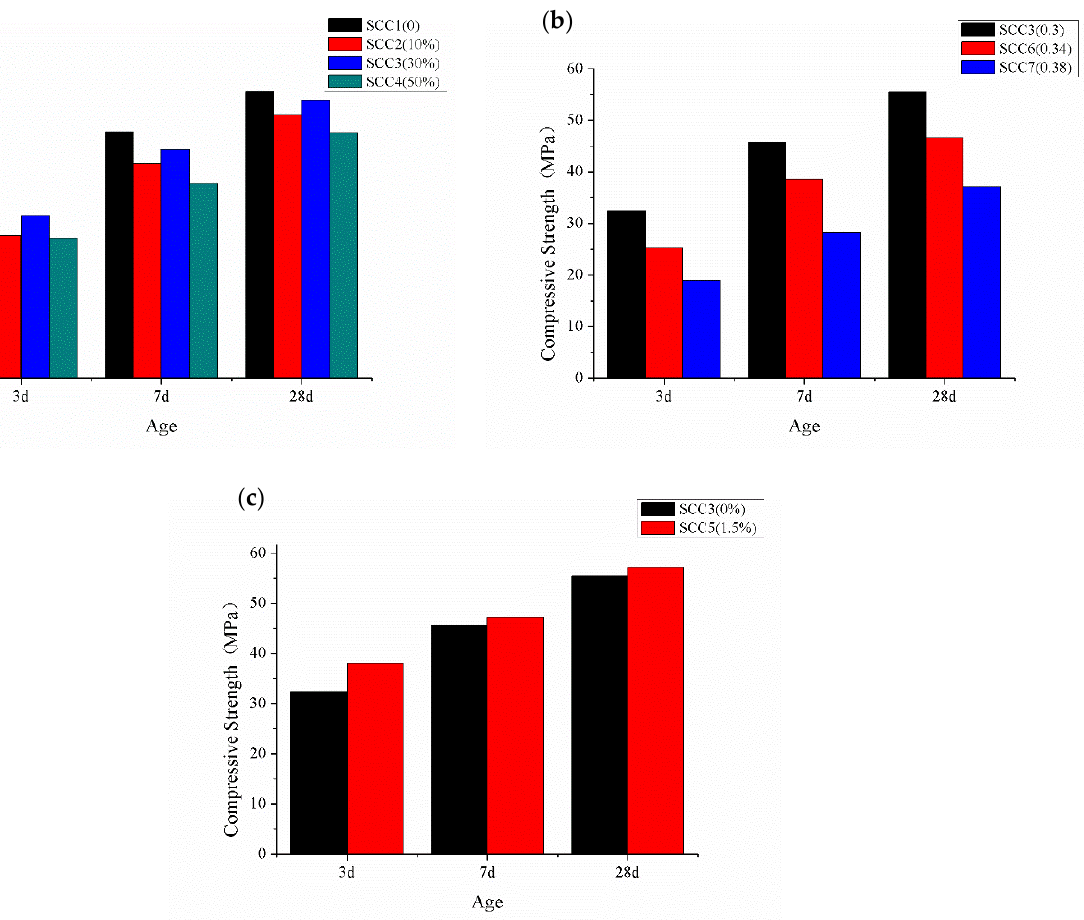
Figure 4. Different influence factors on the compressive strength at different ages. ( a ) amount of GDS; ( b ) W/B; and ( c ) amount of sodium